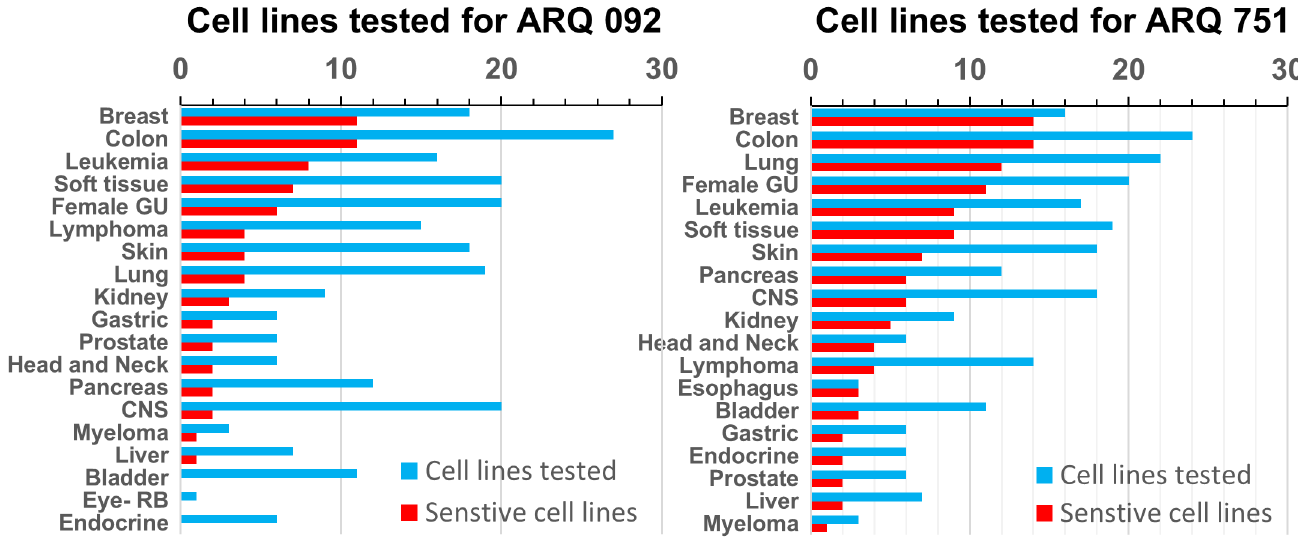
Fig 5. Determination of the sensitivity of ARQ 092 and ARQ 751 with different cancer cell types. Plots of cancer type versus drug sensitivity and number of cell lines per cancer type were prepared for ARQ 092 (left panel) and ARQ 751 (right panel).